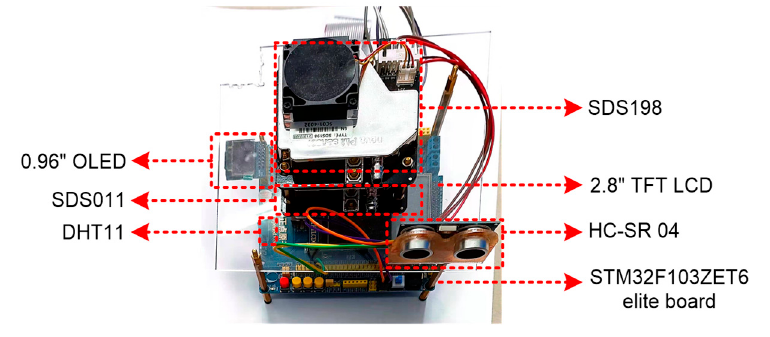
Figure 6. Assembled MSFS and part assignment.